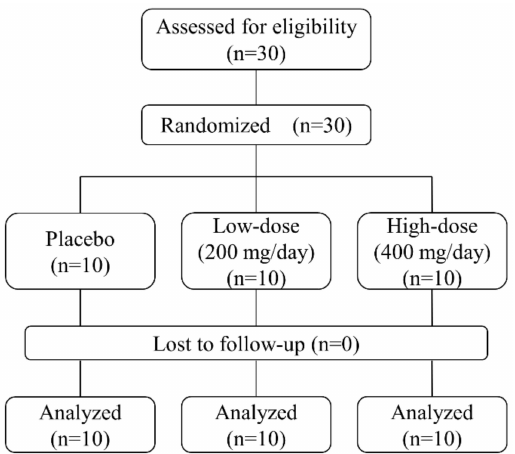
Figure 1. Study participant